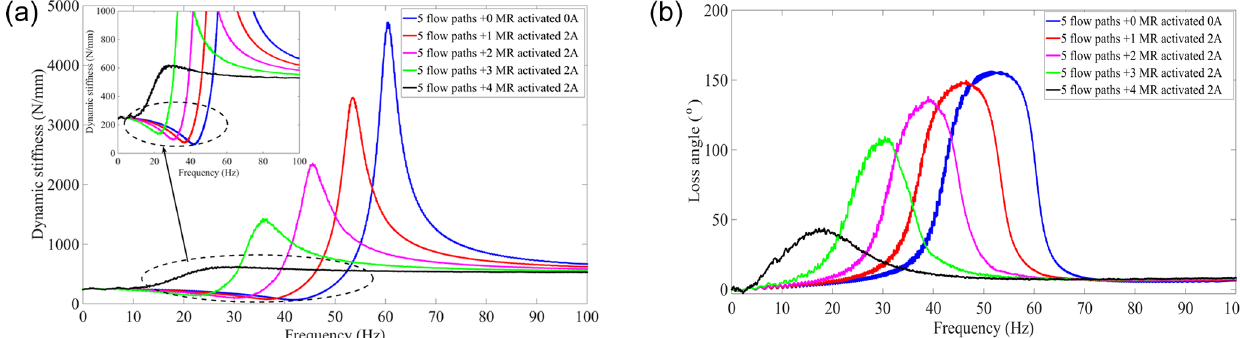
Figure 12. Controllable multi-channel semi-active MR fluid mount dynamic characteristics (a) dynamic stiffness and (b) loss angle.